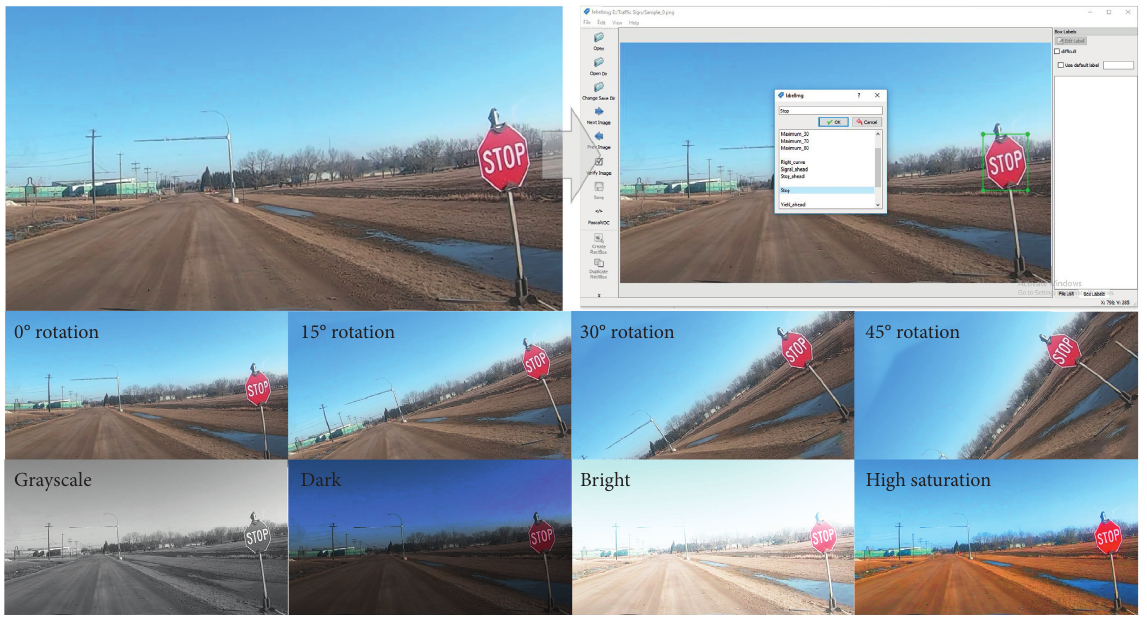
Figure 2: Different stages of data